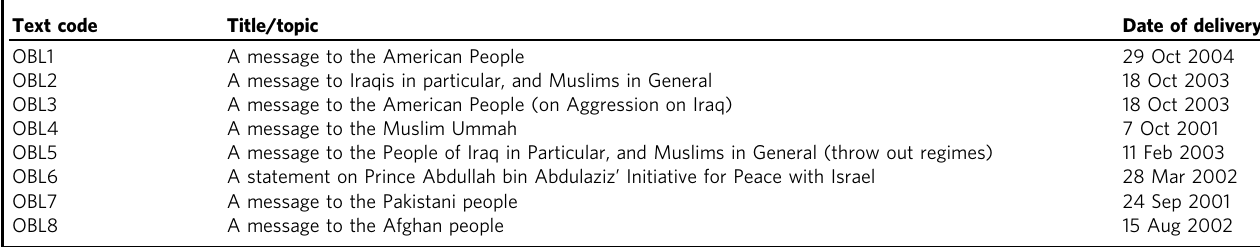
Table 1 Overview of the OBL